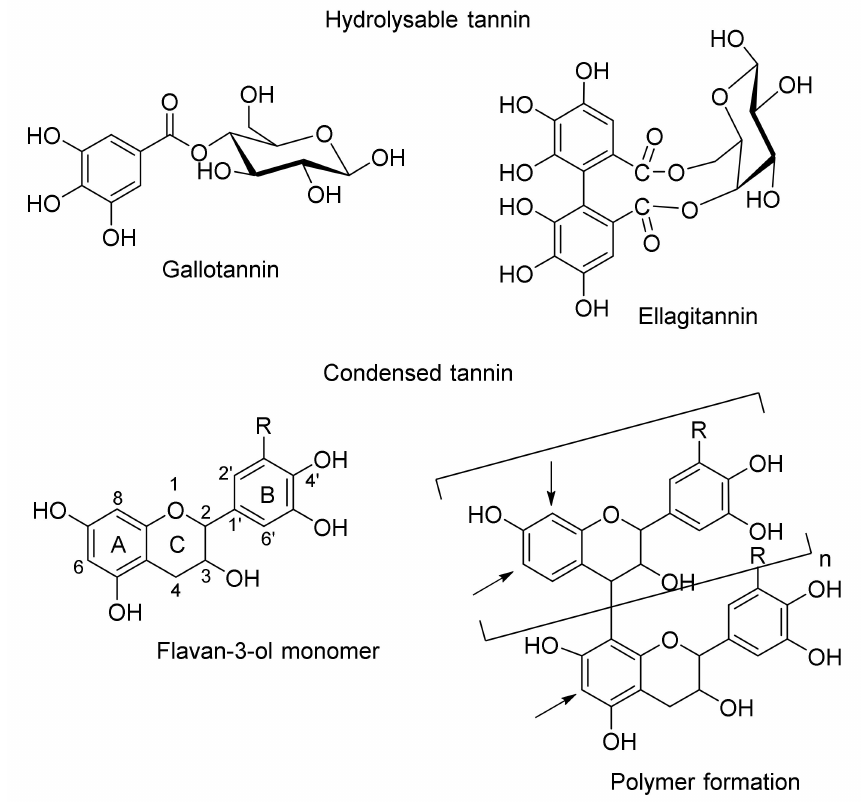
Figure 1. Basic structures of hydrolysable and condensed